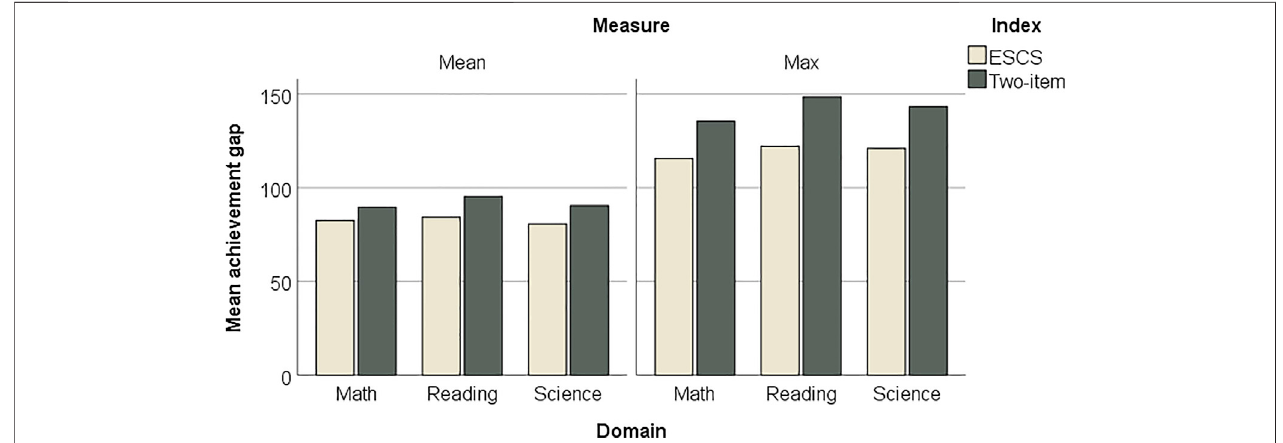
FIGURE 2 | SES achievement gaps for math, reading, and science, estimated either using the composite measure provided by PISA (light bars) or using the new two-item SES index (dark bars). The latter index yielded larger gap estimates, whether looking at mean values across 77 societies (left panel) or the maximal value among all 77 societies (right panel)